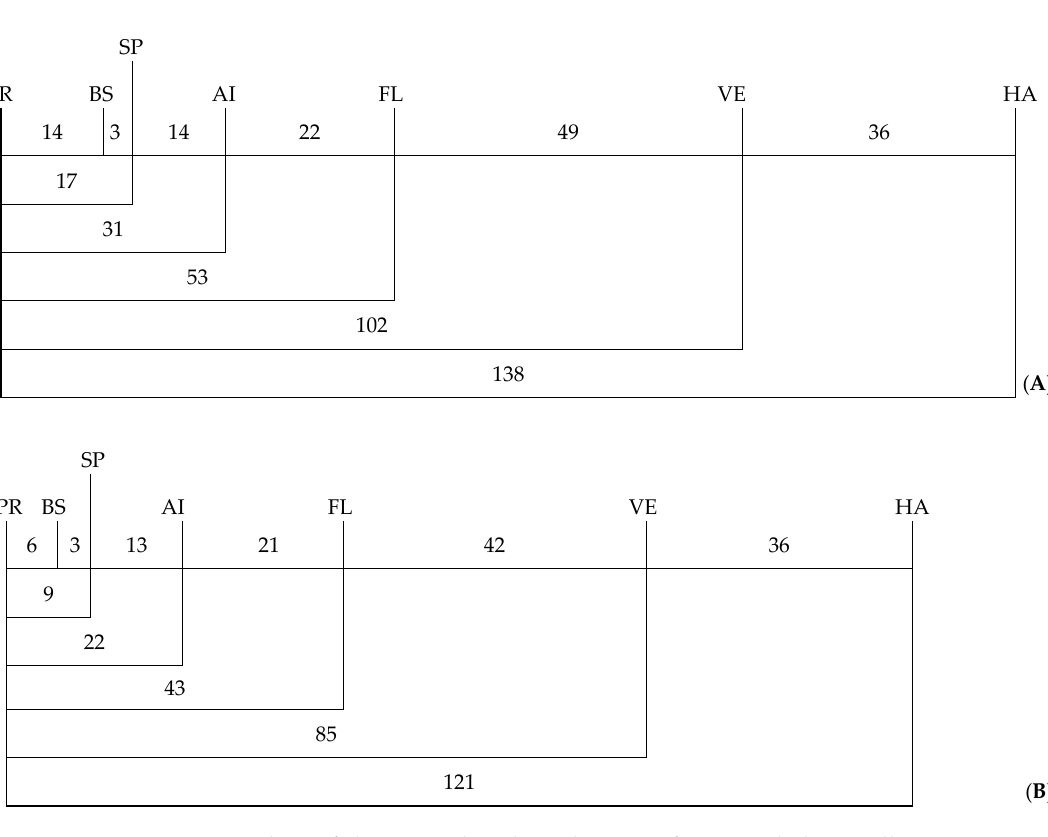
Figure 2. Duration in days of the main phenological stages of ‘BRS Melodia’ seedless grape in a subtropical region. ( A ) Summer cropping season 2013 and ( B ) off-season 2014. Pruning (PR); bud-swell (BS); Sprouting (SP); Appearance of the inflorescence (AI); Flowering (FL); Véraison (VE); and Harvest (HA).